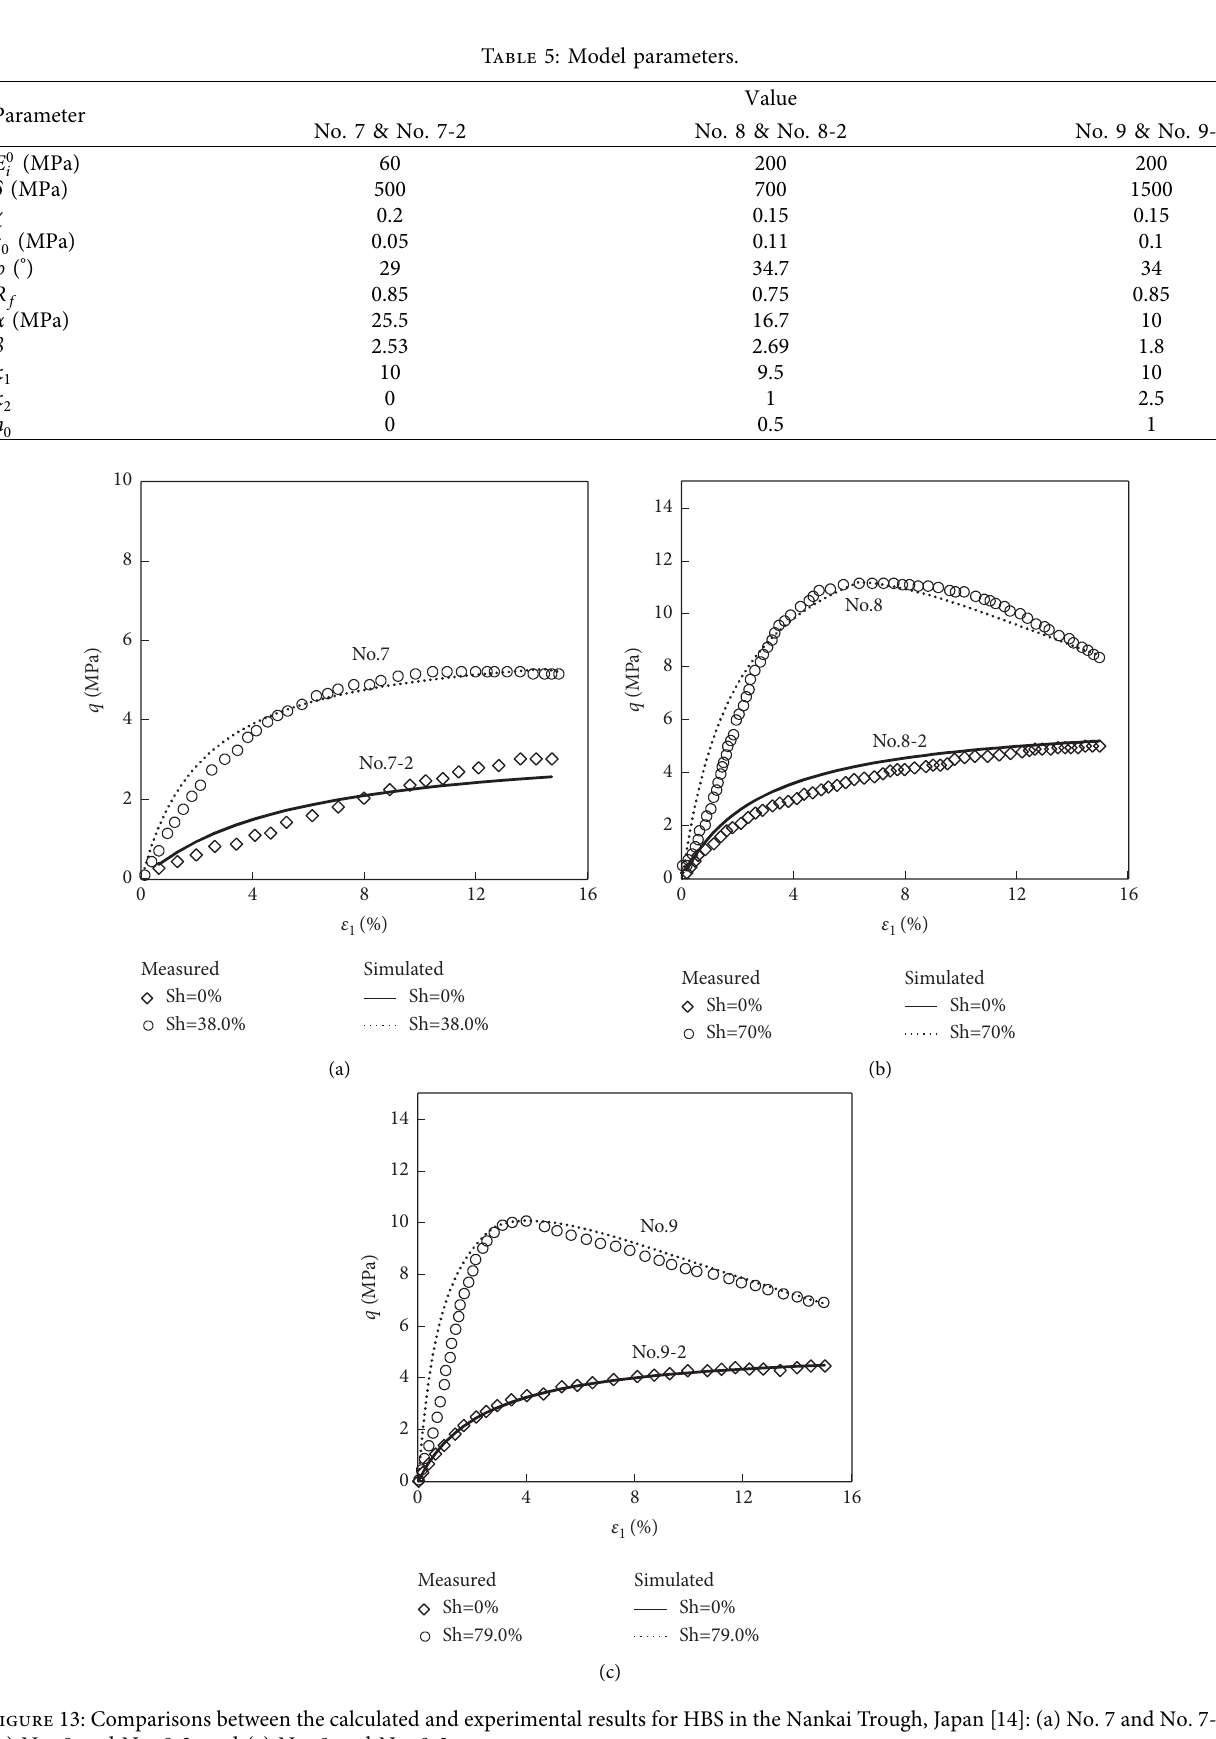
Figure 13: Comparisons between the calculated and experimental results for HBS in the Nankai Trough, Japan [14]: (a) No. 7 and No. 7-2, (b) No. 8 and No. 8-2, and (c) No. 9 and No.